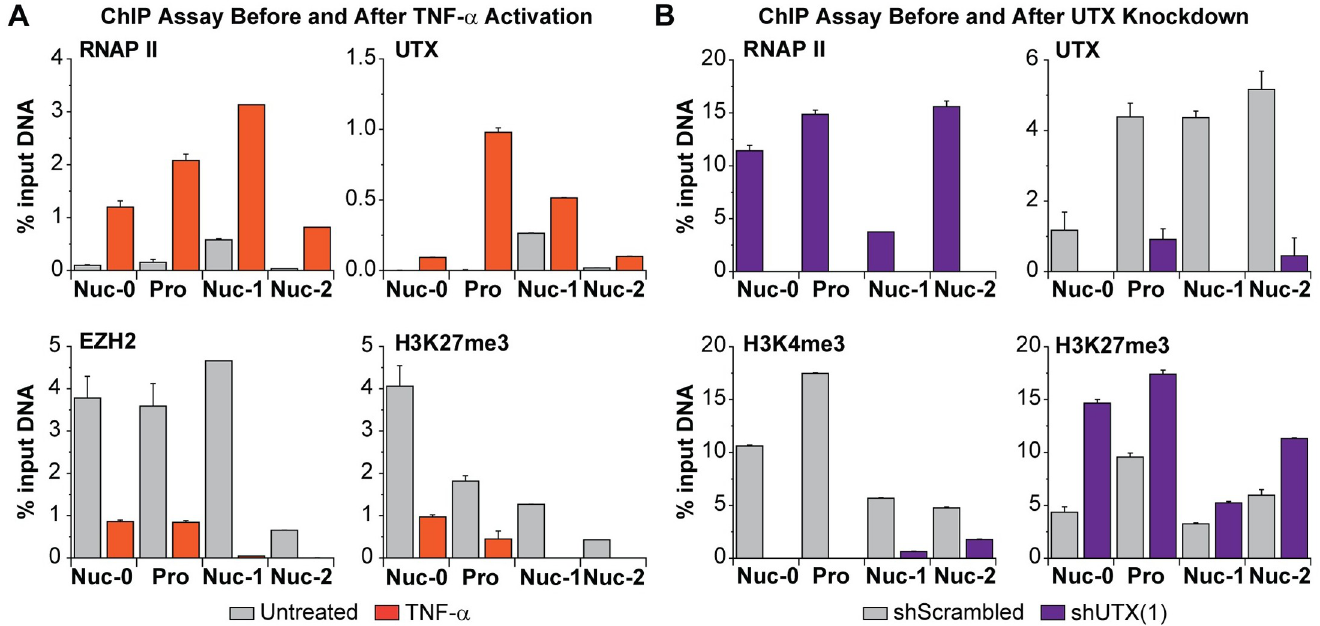
Fig 2. UTX functions as a transcription activator of HIV-1 transcription. (A) ChIP assays measuring the enrichments of RNAP II, UTX, EZH2, and H3K27me3 at the Nuc-0, HIV-1 promoter, Nuc-1, and Nuc-2 regions of HIV-1 before or after TNF- α reactivation. Latent proviruses in E4 cells were reactivated by TNF- α (10 ng/ml) for an hour. Cells were treated with ethylene glycol bis(succinimidyl succinate) (EGS) (1.5 mM) for 30 minutes and subsequently crosslinked with formaldehyde (1%) for additional 10 minutes. (B) ChIP assays measuring the enrichment of RNAPII, UTX, H3K4me3, and H3K27me3 along HIV-1 genome in one UTX knocked down clone. Error bars: SEM of 3 separate quantitative real-time PCRs. Note that Nuc-0 and HIV-1 promoter primers amplify both 5’LTR and 3’LTR of HIV-1; Nuc-1 and Nuc-2 primers specifically bind to 5’LTR.